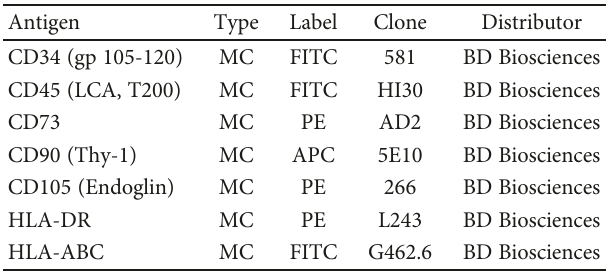
Table 1: Antibodies used for fl ow